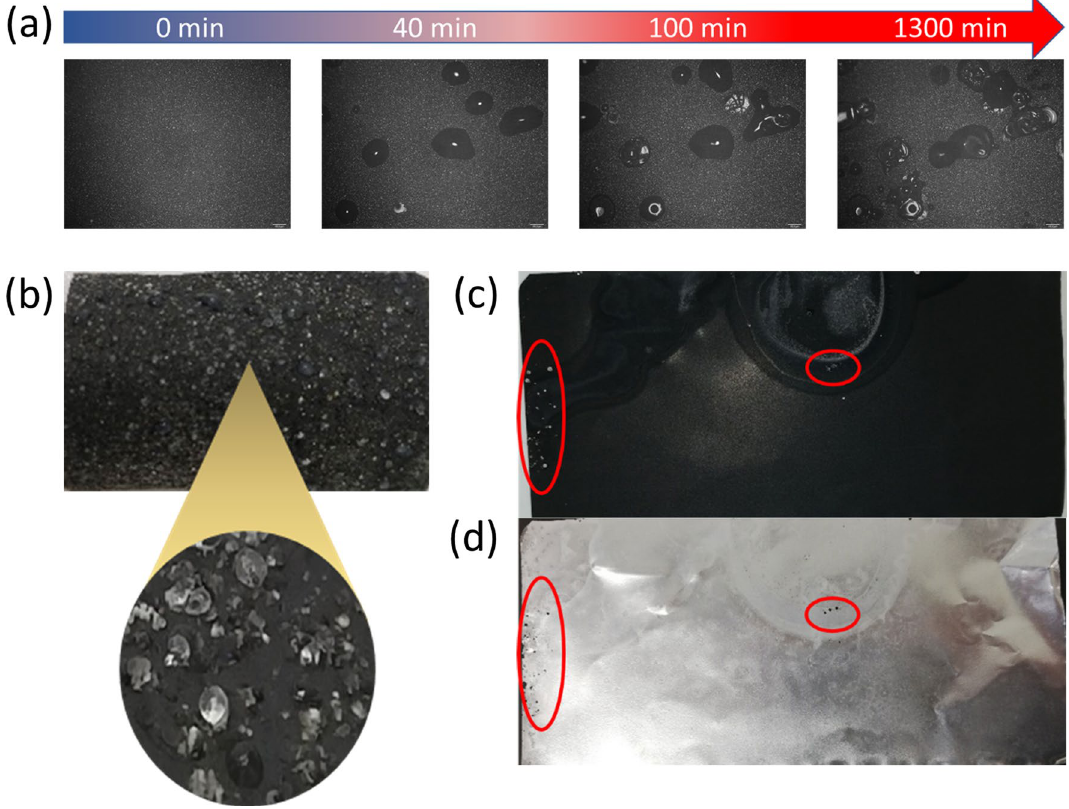
Figure 1. ( a ) Time sequence of the accumulation of moisture on the surface of a positive electrode; humidity of φ = 100%, 2.55 mm × 1.91 mm; ( b ) Precipitations on a positive electrode surface (removed from a